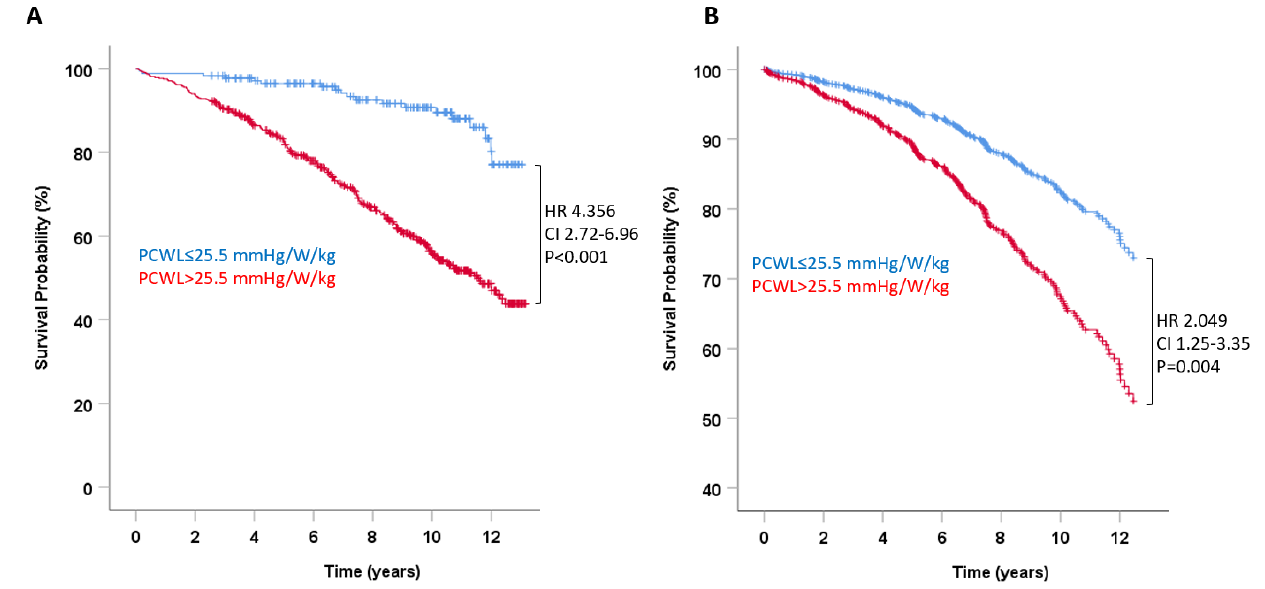
Figure 3. Pulmonary capillary wedge pressure during exercise and survival in heart failure. Survival probability in patients with normal (≤25.5 mmHg/W/kg) and pathologic (>25.5 mmHg/W/kg) response to exercise, expressed as peak exercise to workload normalized to body weight. ( A ) Unadjusted survival probability; ( B) survival probability adjusted for clinical and echocardiographic variables that predicted mortality in univariate analysis (see Table 1).